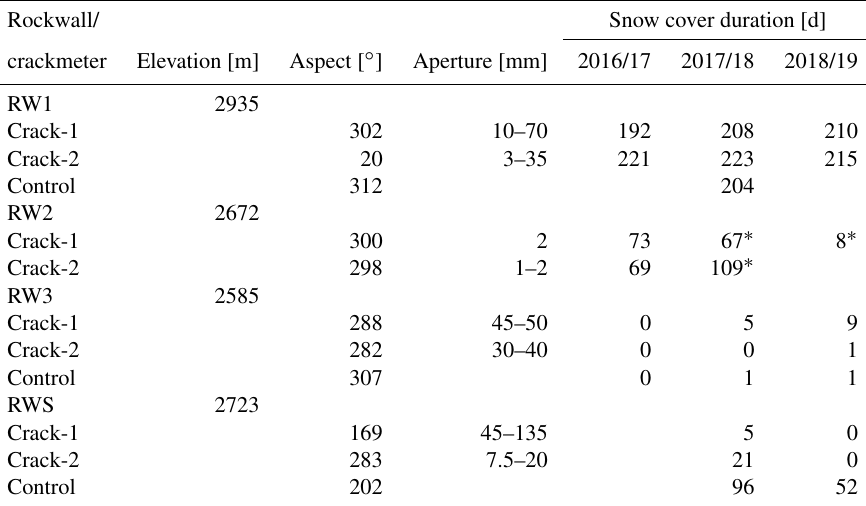
Table 2. Properties of instrumented fractures and observed snow duration at each